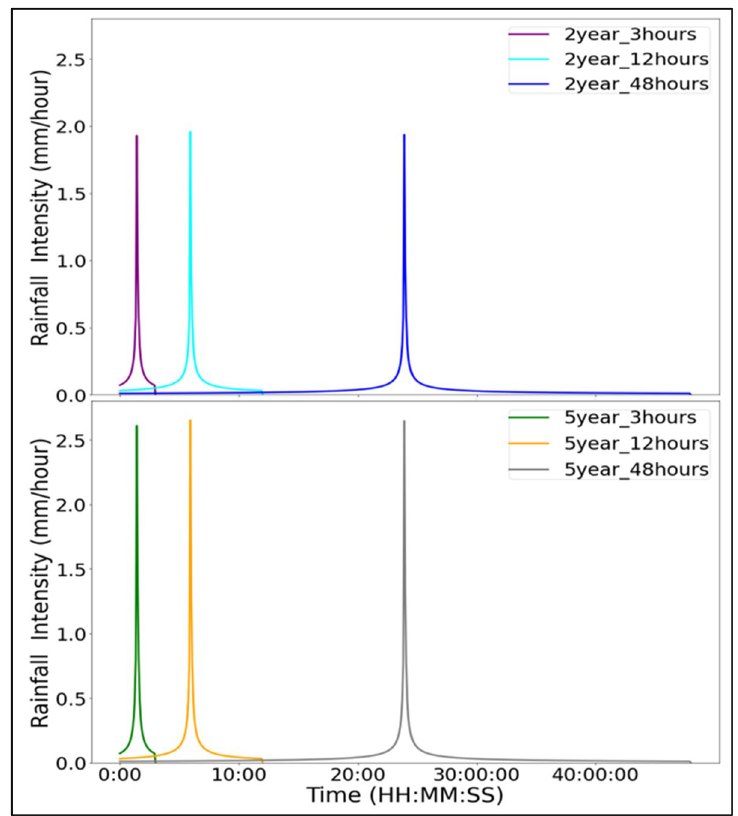
Figure 4. Distribution plots of artificially designed rainfalls with di ff erent return periods and rainfall duration.